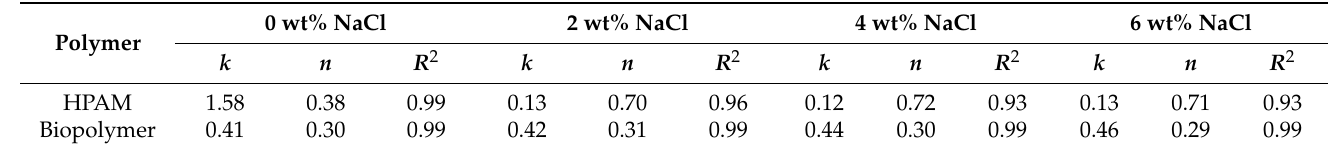
Table 4. Effect of salt content on the shear viscosity of polymer systems.